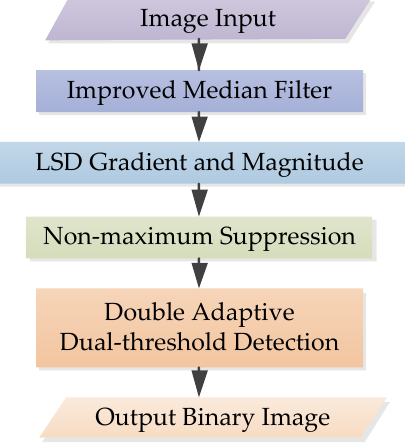
Figure 4. The flowchart of improved Canny